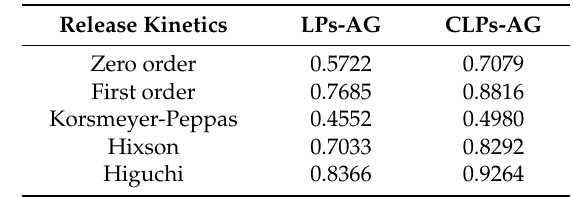
Figure 3. In vitro release profiles of LPs-AG and CLPs-AG in PBS. (each data point represents the average of three samples). Table 4. Regression coefficient (R 2 ) obtained in different kinetics models for AG release from LPs-AG and CLPs-AG.